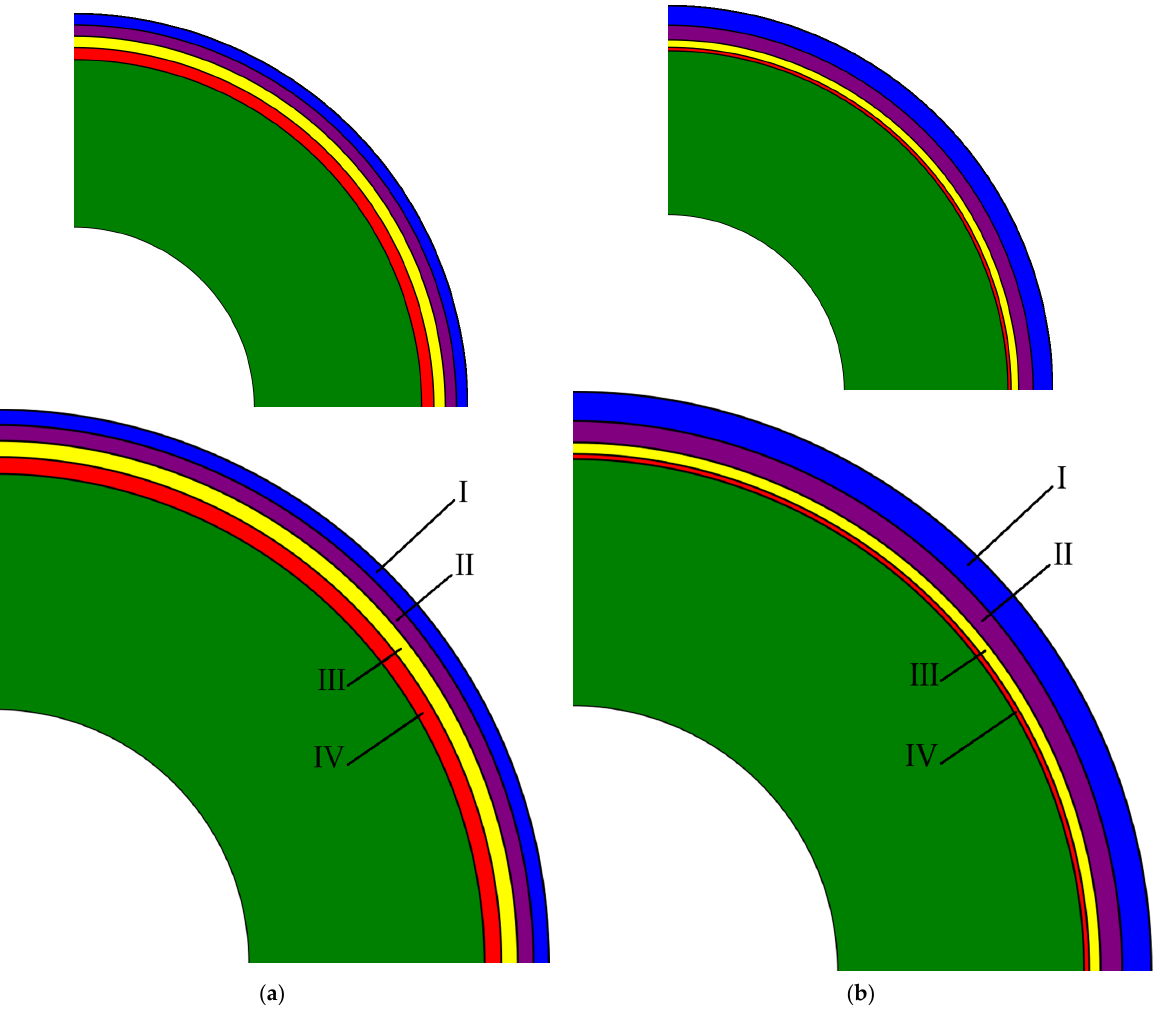
Figure 3. Visualization of the volumetric fractions of the radial layers of the control rods: ( a ) St_struc, equal volumes; ( b ) St_opt, optimized structure. The innermost central section (green) is made of B 4 C dispersed in graphite, while the others are made of tungsten.